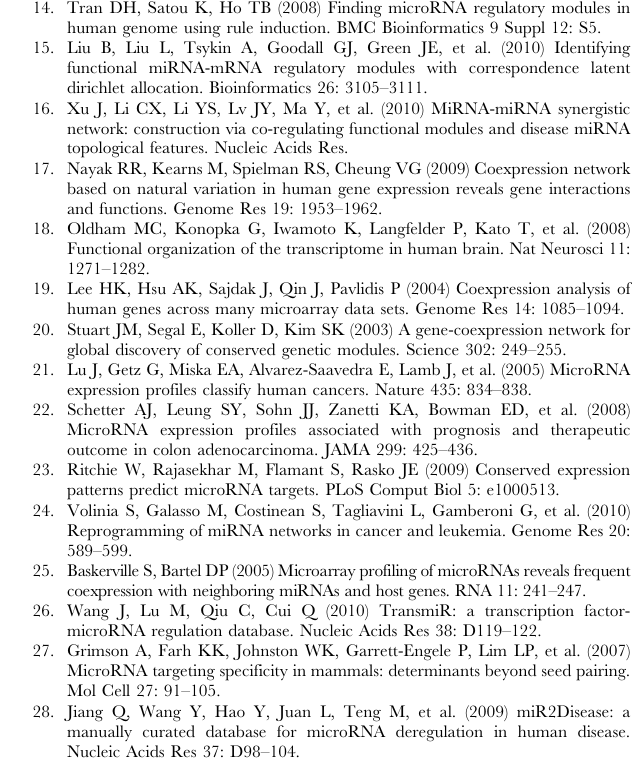
Figure S1 Probability density of the Pearson correlation coefficients of the 44 co-expressed miRNA pairs belonging to the same family. The Pearson correlation coefficients were calculated using three deep sequencing- and one PCR-based expression data sets. Figure S2 Functional relationships of 138 conserved co- expressed miRNA pairs not belonging to the same family. (A)